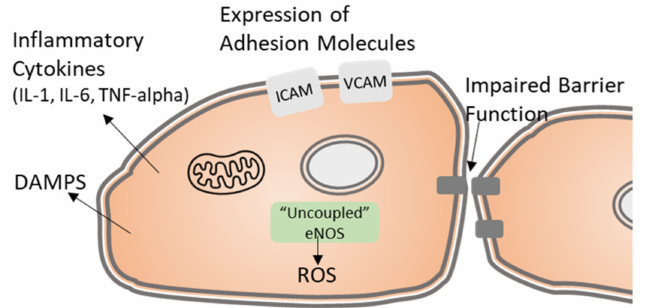
Figure 2. Schematic depiction of the mechanisms which contribute to radiation-induced endothelial cell